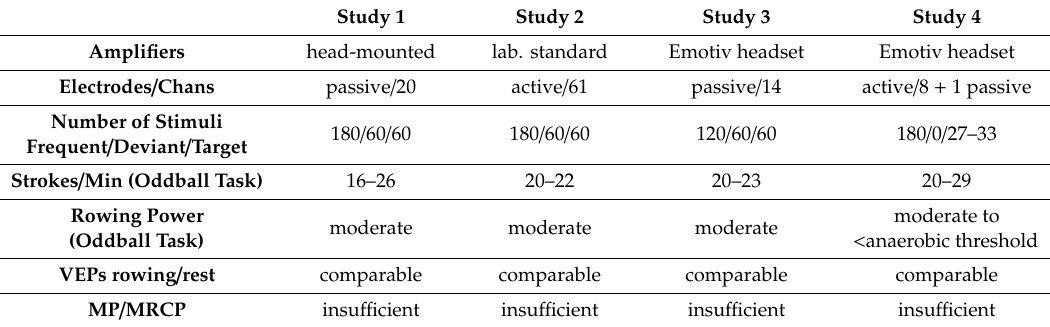
Table 1. Overview of key indicators of the four pilot